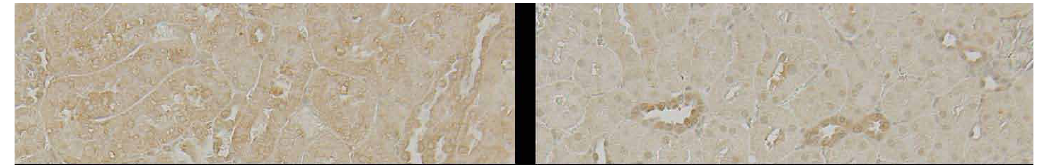
Figure 1 - Immunohistochemistry Renal tissue stained with a TGF-beta antibody (sc-146, Santa Cruz Biotechnology Inc., Santa Cruz, California, U.S.A).